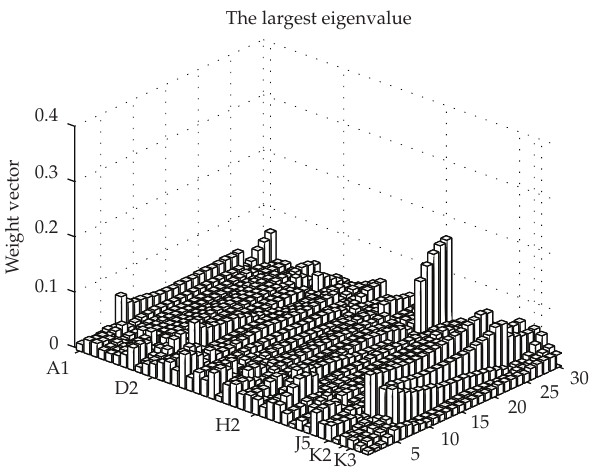
Figure 10: The pattern of P2P tra ffi c, monitored by B4, D5, J5, and D2. For each peer in the group A1, D2, J5, K2, and K3, rate (cid:8) 25, starting time (cid:8) 125. Then peers of D2 leave at t (cid:8) 160 and peers of H2 join in at t (cid:8) 200 with rate (cid:8)